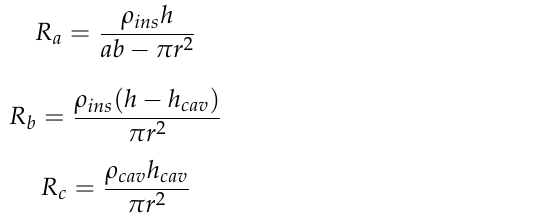
Table 5. Capacitive–Resistor Model’s Parameters (h, r).